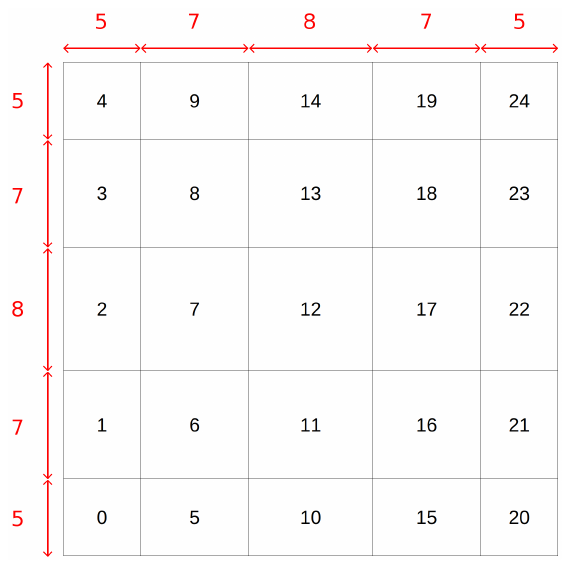
Figure 8. Top view to the active volume of the TPC subdivided into 25 regions labelled with black numbers between 0 and 24. The red numbers denote the width and the length of each region in units of conducting